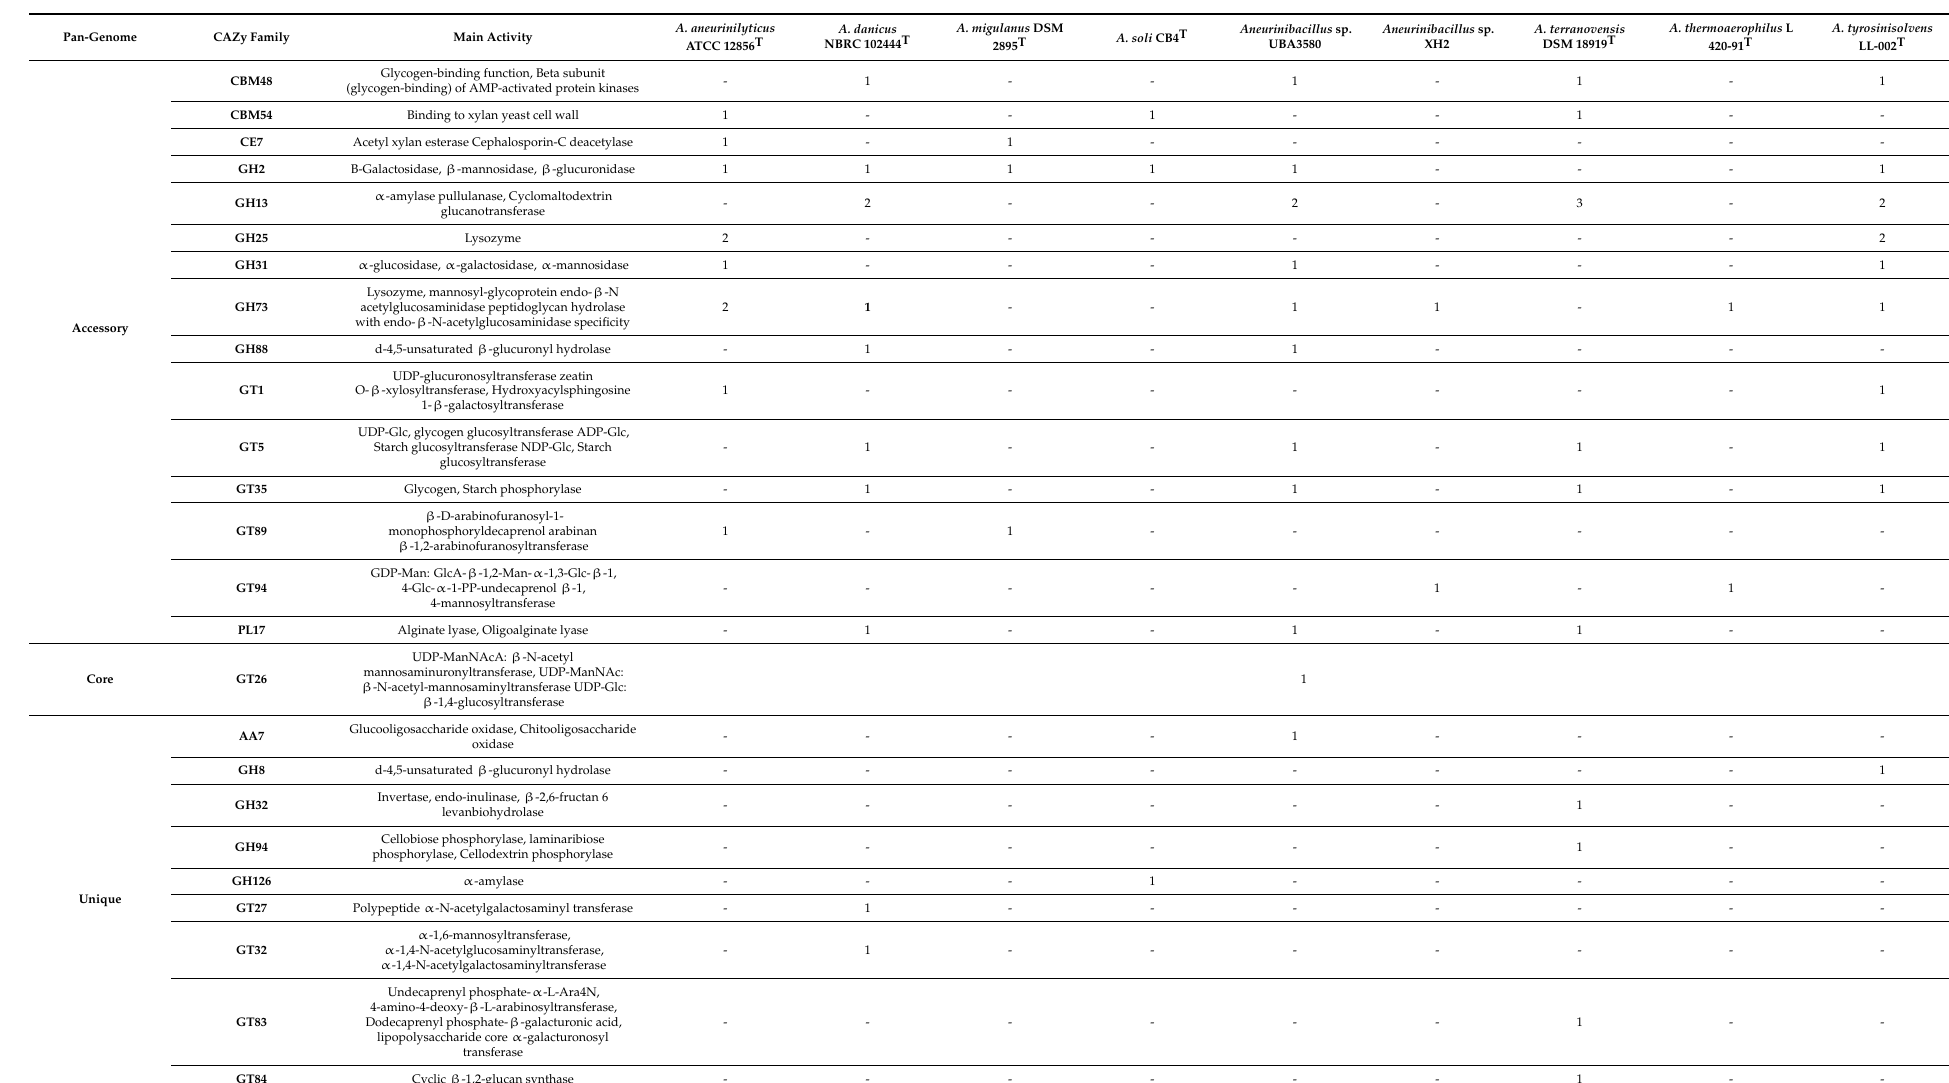
Table 4. Number of specific CAZy families for accessory, core and unique genomes of Aneurinibacillus . In case of multiple activities, only the first three are reported.